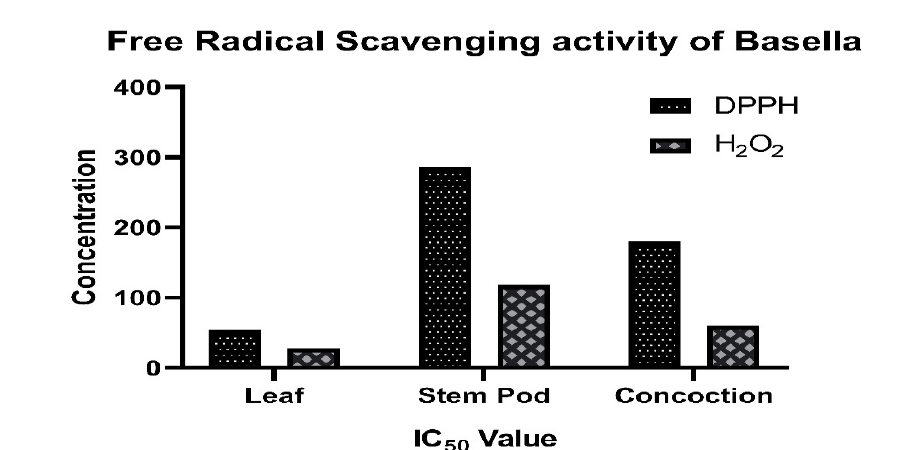
FIGURE 6 - Antioxidant activities of Basella